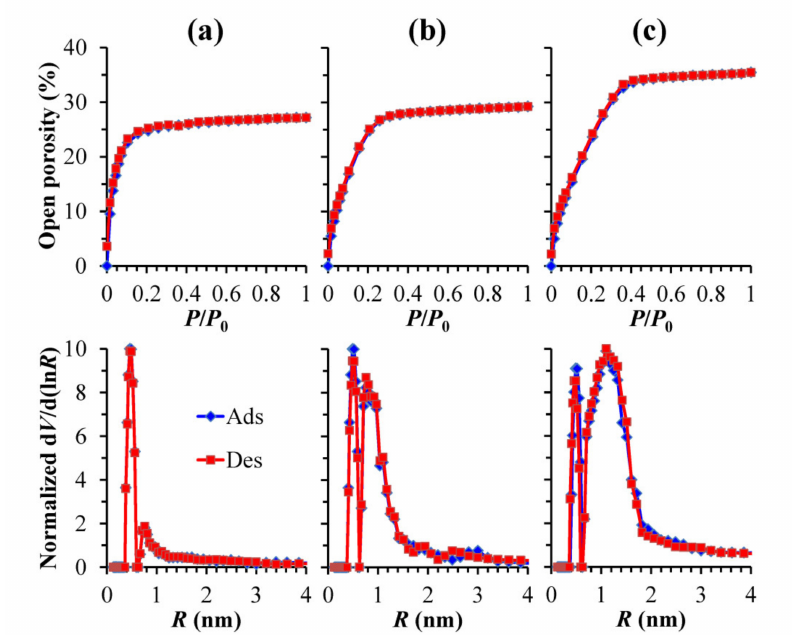
Figure 8. Adsorption–desorption isotherms of isopropyl alcohol vapor and pore size distribution in low- k films deposited with di ff erent ratios of methyltrimethoxysilane to 1,4-bis(triethoxysilyl)benzene (MTMS / BTESB) mixture: ( a ) 40 / 60, ( b ) 55 / 45 and ( c ) 75 / 25.